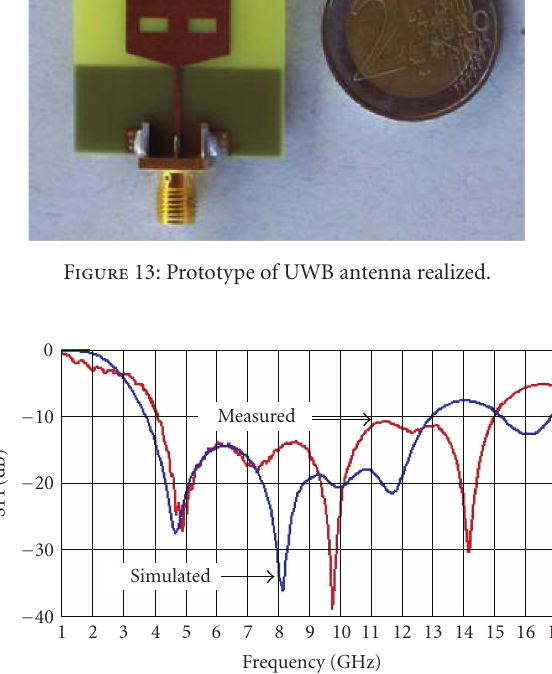
Figure 14: Simulated (blue) and measured (red) S11 parameters of the UWB antenna of Figure